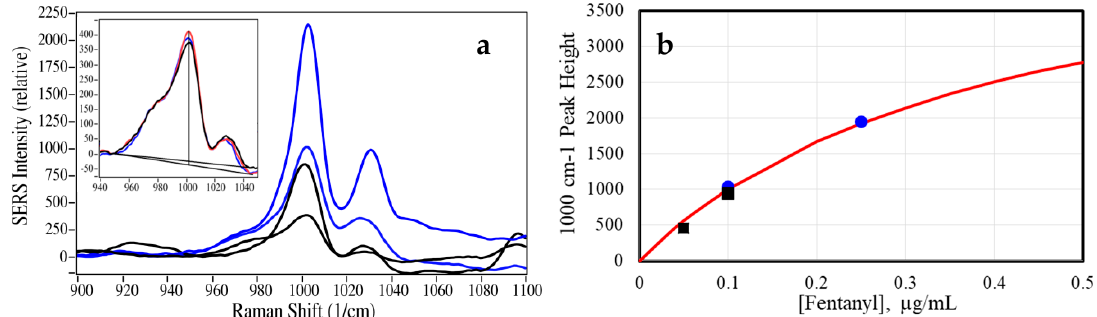
Figure 7. ( a ) SERS of 50 and 100 ng/mL fentanyl from glass surface (black), and 100 and 250 ng/mL fentanyl reference spectra (blue). Inset: Three individual 50 ng/mL sample spectra (note baseline-corrected heights). ( b ) Concentration plot showing corresponding peak heights (black squares, baseline tilt corrected) with reference samples (blue circles). Conditions: 40 mW at 785 nm, 3-sec scan per sample, three spectra averaged (except inset). No spectral smoothing was necessary.